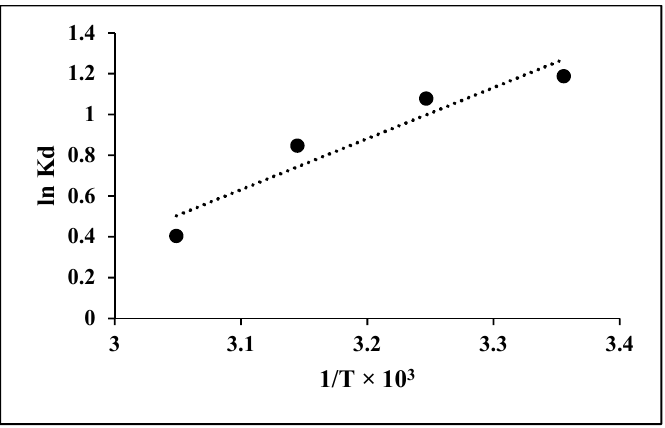
Figure 10. Van’t-Hoff’s plot for adsorption of ENR using GA-MNPs. Table 9. Thermodynamic parameters for the adsorption of CIP